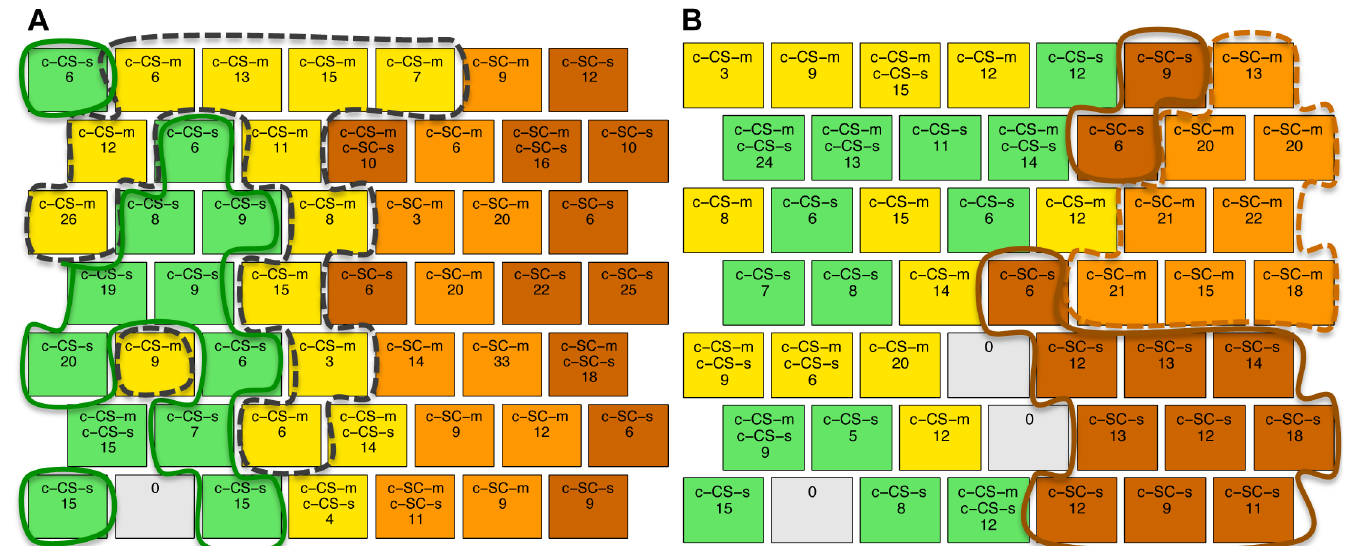
Fig 5. SOM clustering with data from the 11 proteins that discriminate between context-shock and shock-context (c-CS and c-SC) plus. (A) the 12 proteins that discriminate between context-shock with and without memantine (c-CS-m and c-CS-s). Dashed black line, clusters of CS-m; green outline, clusters of CS-s. (B) the 13 proteins that discriminate between c-SC-m and c-SC-s. Brown outline: c-SC-s clusters; orange dashed outline: c-SC-m cluster.